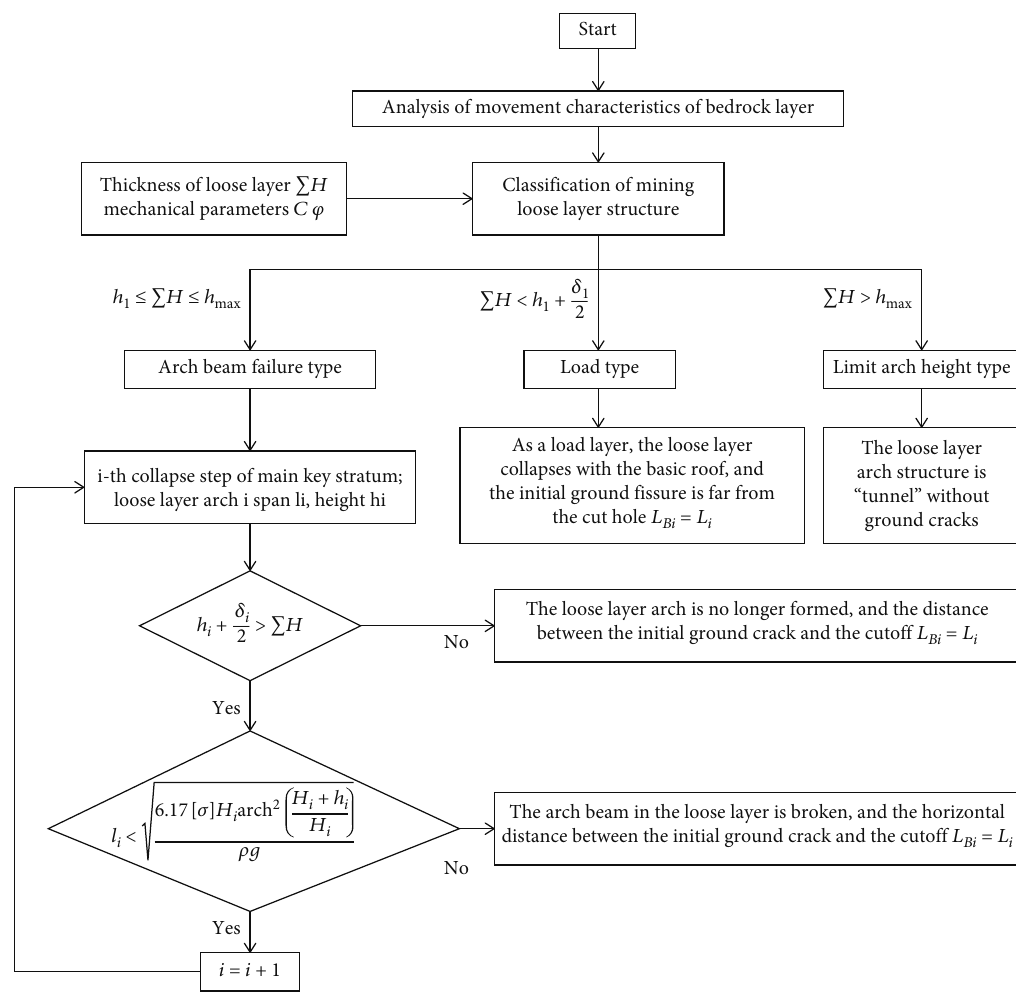
Figure 14: Prediction process for initial ground fi